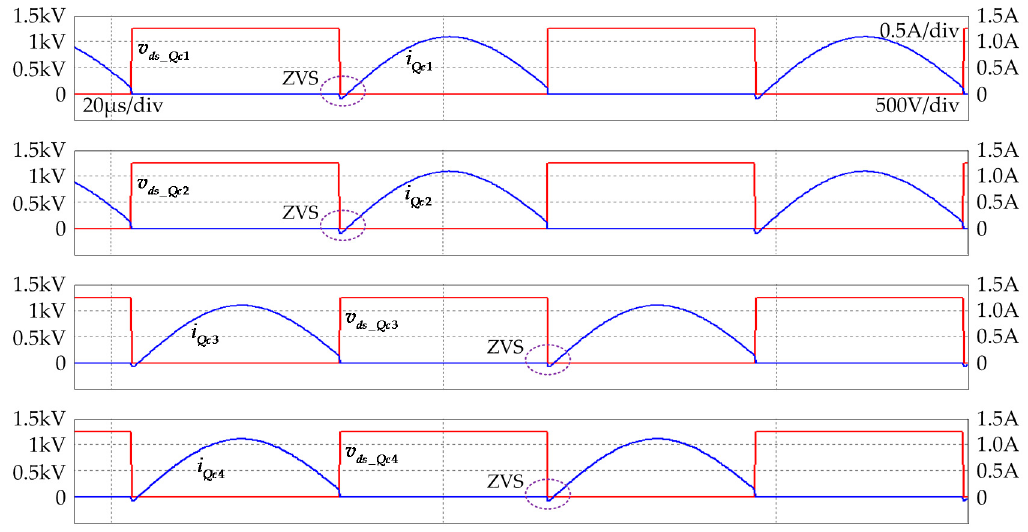
Figure 14. Switching waveforms of the drain to source voltages and the channel current in metal oxide semiconductor field effect transistors (MOSFETs) of the LLC converter.